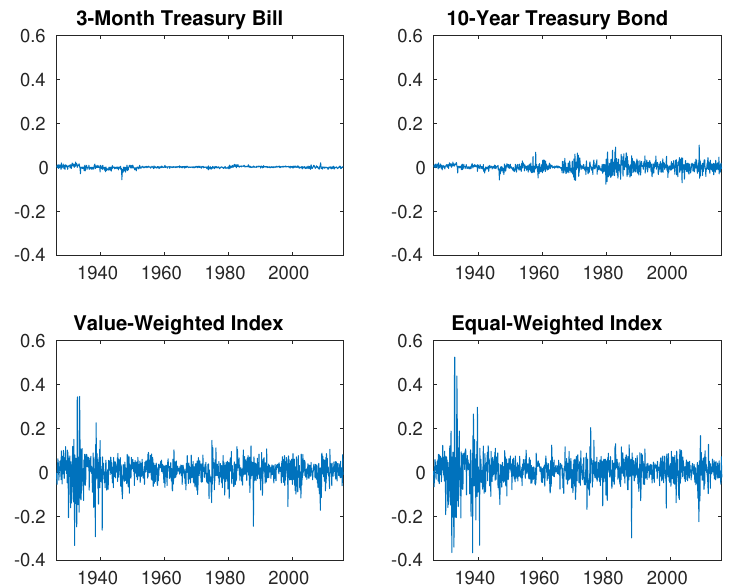
Figure 1. Monthly real returns for US investment indexes, 1926–2015.